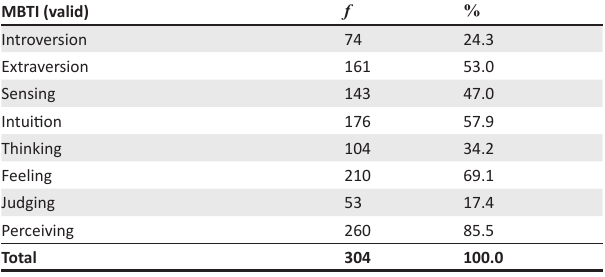
TABLE 2: Frequency distribution of the Myers-Briggs Type Indicator ( N = 304).